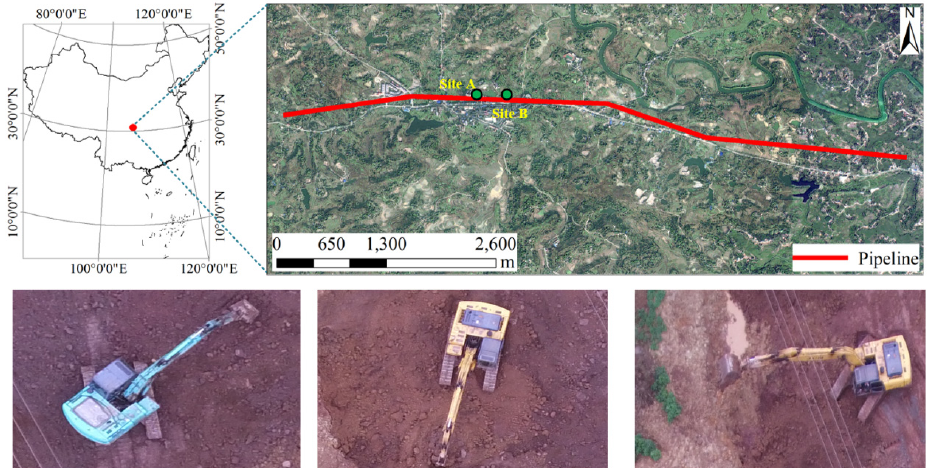
Figure 2. Area for testing the proposed approach and UAV for excavator detection (UAV-ED) system and the images with excavators taken by the UAV in the experiment. The green solid points in the map denote the sites where the excavators were working.